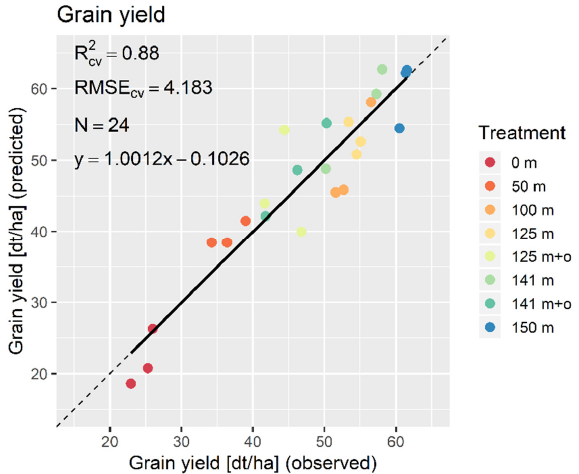
Figure 11. Scatterplot of leave-one-out cross-validated multiple linear regression (MLR) models for grain yield with the regression line (continuous) and the 1:1 line (dashed).